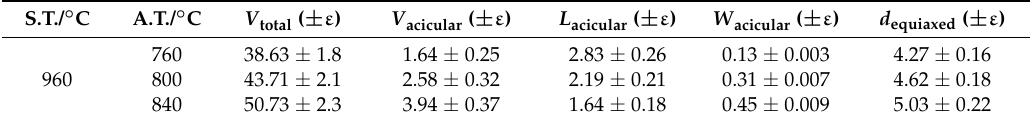
Table 2. The main parameters of the microstructures during various heating treatment. V total (%), V acicular (%), L acicular ( µ m), W acicular ( µ m) and d equiaxed ( µ m) are the volume fraction of total precipitates, acicular O phase, the length of acicular O, the width of acicular O, and the diameter of equiaxed particles, respectively. ε is the average errors.